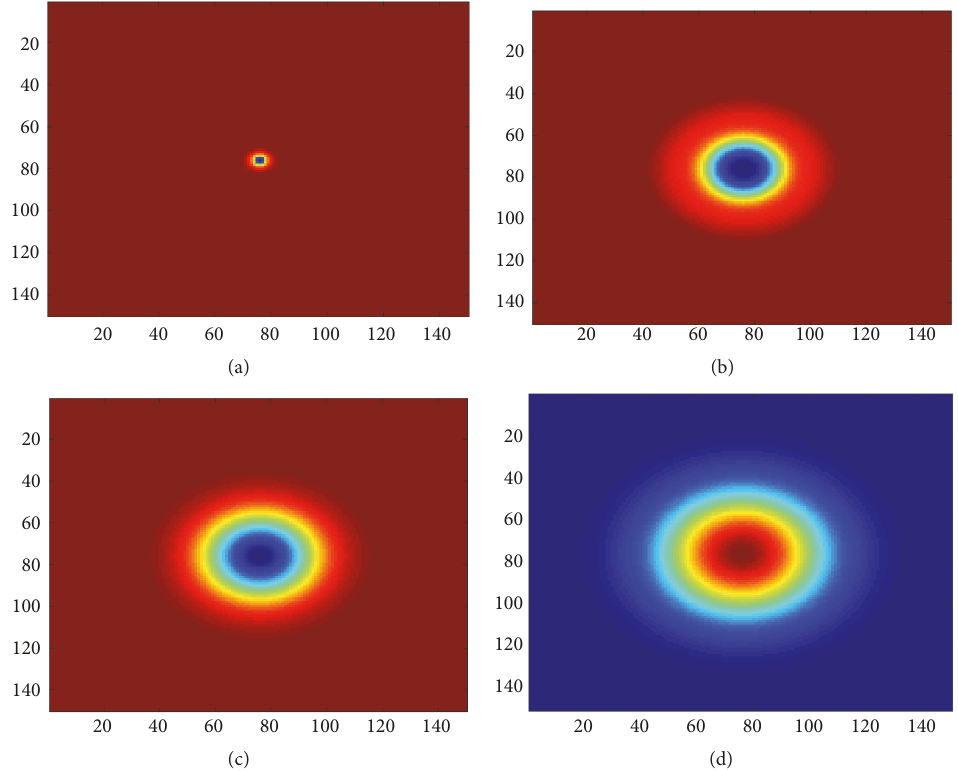
Figure 12: The snapshots of spatial distribution of membrane potential with color scale for neurons in the square array network for 𝑘 = 1 and 𝐷 = 5 at (a) 𝑡 = 2 time units, (b) 𝑡 = 75 time units, (c) 𝑡 = 135 time units, and (d) 𝑡 = 300 time